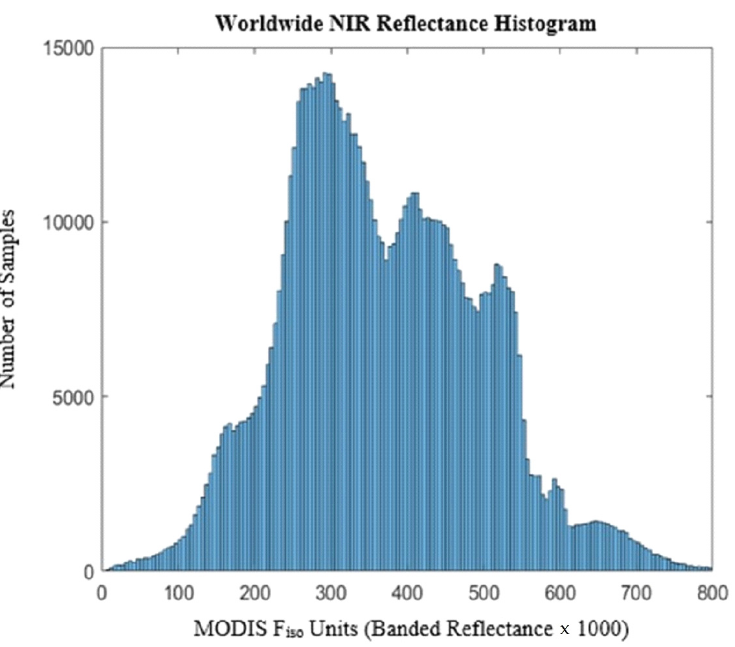
Figure 6. Banded NIR reflectance of barren classified pixels across Africa, South America, Australia, and Asia in MODIS units (reflectance × 1000). Note there are three distinct peaks in the histogram, which are continent dependent.